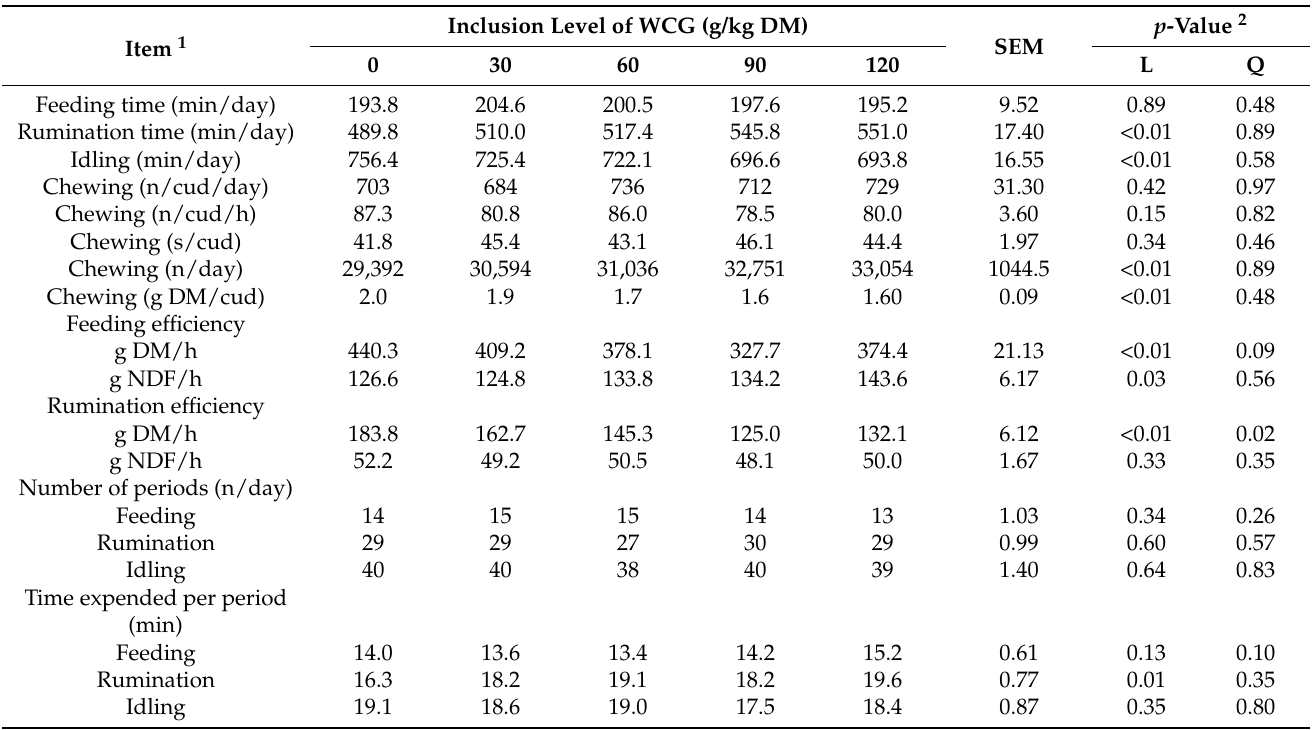
Table 5. Feeding behavior of lambs fed diets containing whole corn germ.